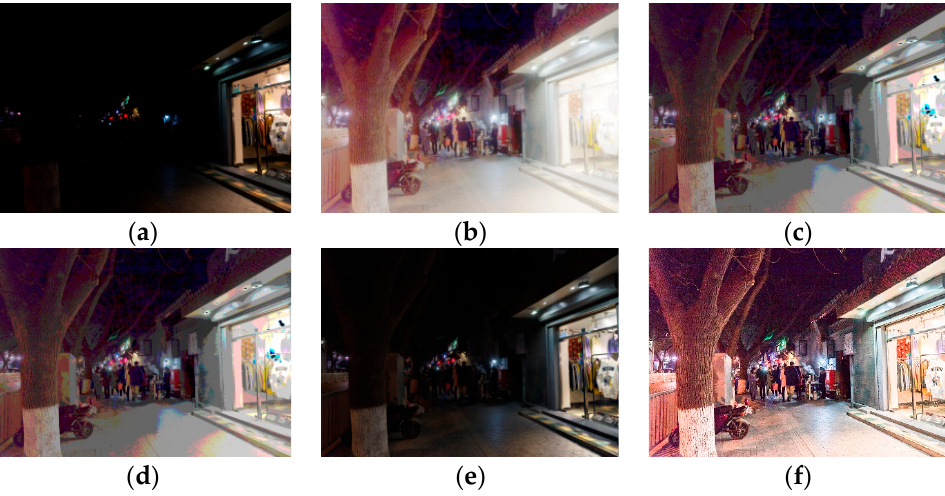
Figure 1. Enhancement result of traditional methods: ( a ) original, ( b ) MSR, ( c ) log transform, ( d ) CLAHE, ( e ) gamma, and ( f ) ours. ( d ) CLAHE, ( e ) gamma, and ( f )